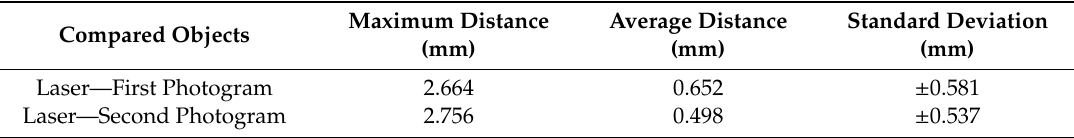
Table 4. Statistical indices obtained from the comparisons between the laser-scanning model and the photogrammetric